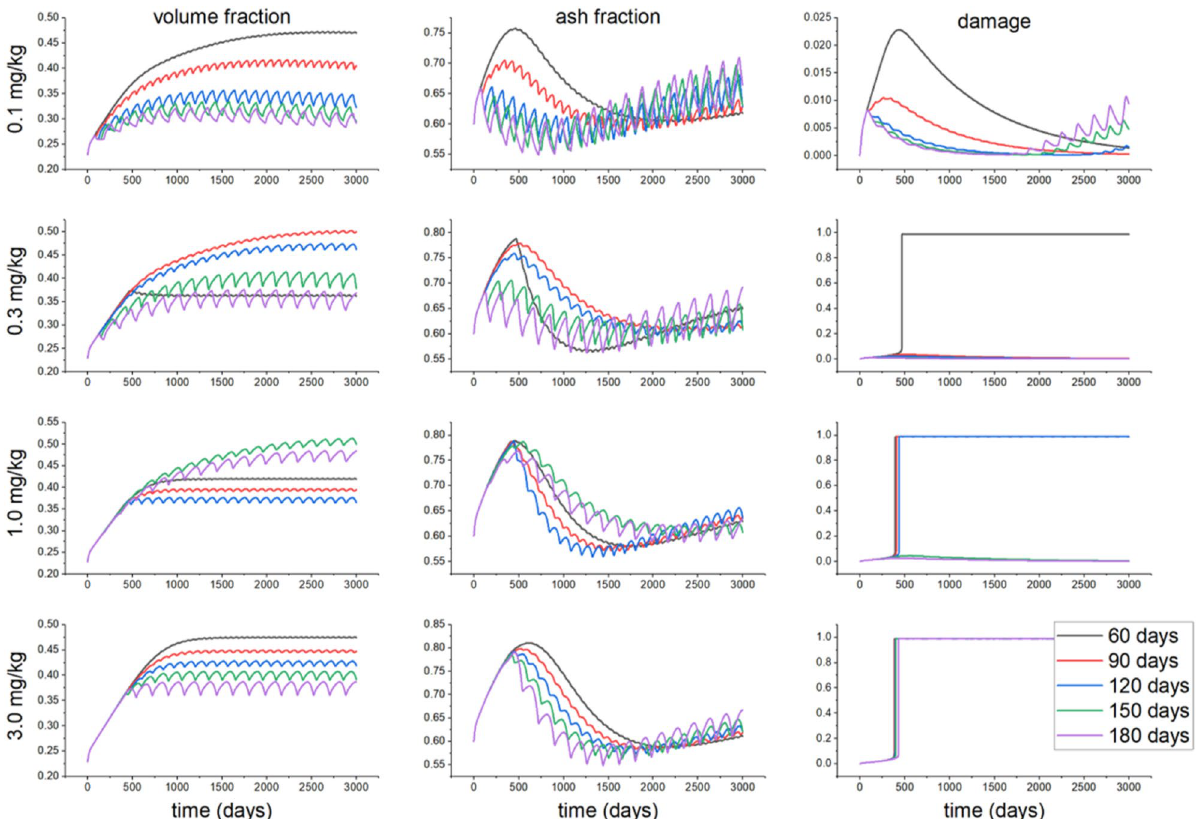
Figure 4. Evolution of the volume fraction, ash fraction and damage for different doses of denosumab (0.1, 0.3, 1.0 and 3.0 mg/kg) when applying a stress of 1.0 MPa for a bone initial density of ρ dosage time intervals of 60, 90, 120, 150 and 180